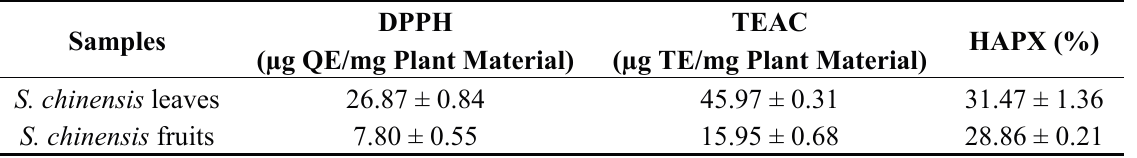
Table 3. Antioxidant capacity parameters obtained using several methods for studied